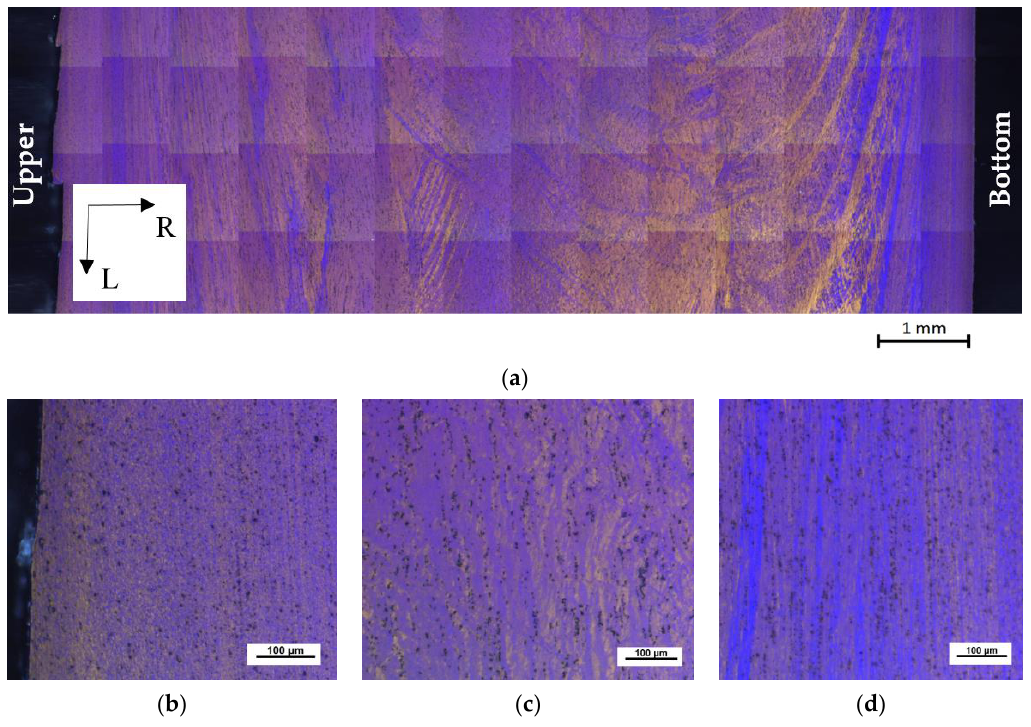
Figure 7. Material microstructure after ECAP – Conform processing taken on the LR section: ( a ) overall image; ( b ) upper and ( d ) bottom surface showing long, thin grains in the surface vicinity; ( c ) massive grains in the central region. Barker’s etching was used.